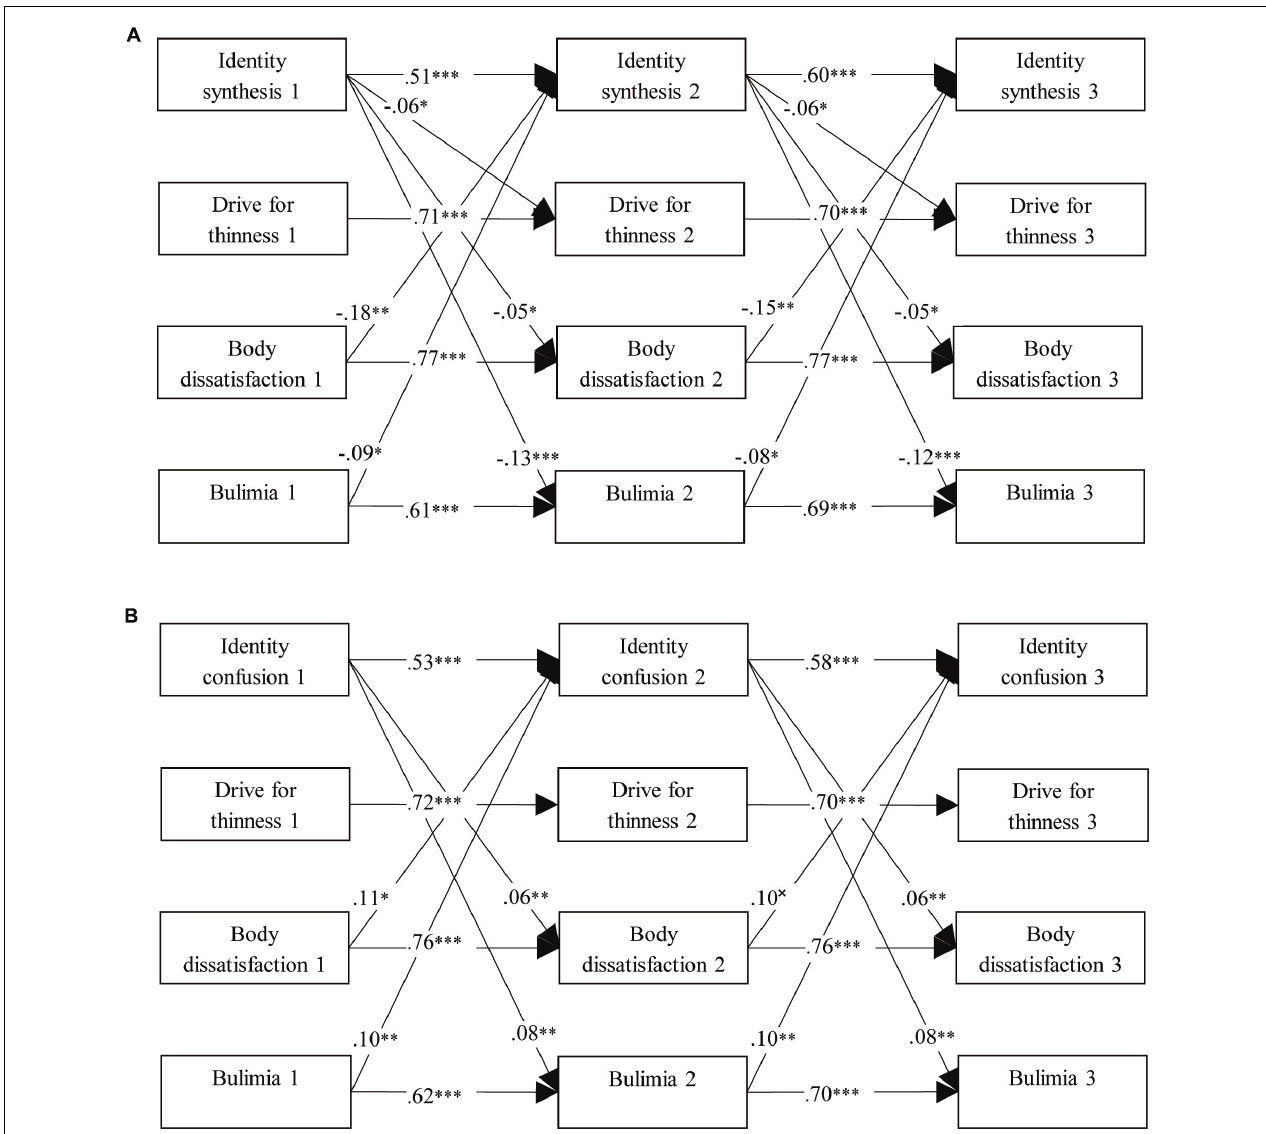
FIGURE 1 | Final cross-lagged models linking ED symptomatology to (A) identity synthesis and (B) identify confusion. Both models were controlled for age and gender. Within-time associations, associations with age and gender, and insignificant cross-lagged paths were not shown for reasons of clarity. All path coefficients are standardized. × p = 0.05, ∗ p < 0.05, ∗∗ p < 0.01, ∗∗∗ p <